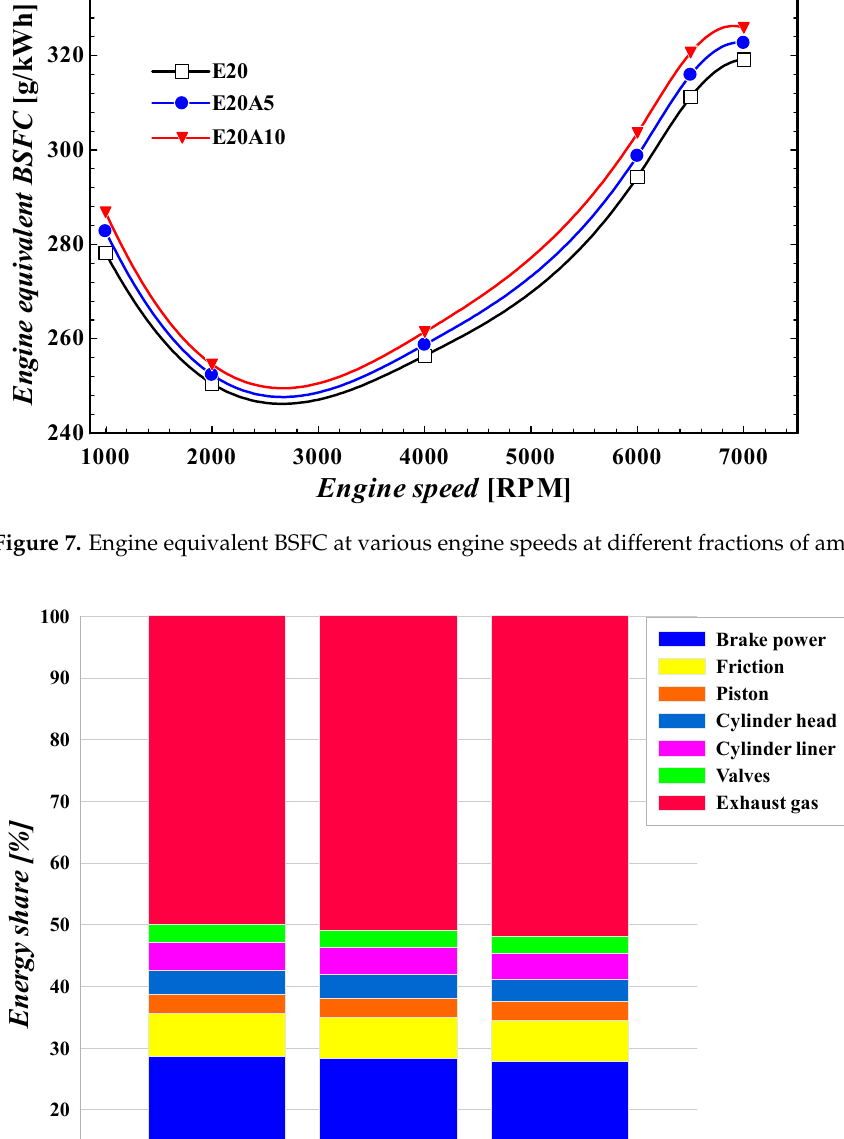
Figure 7. Engine equivalent BSFC at various engine speeds at different fractions of ammonia.